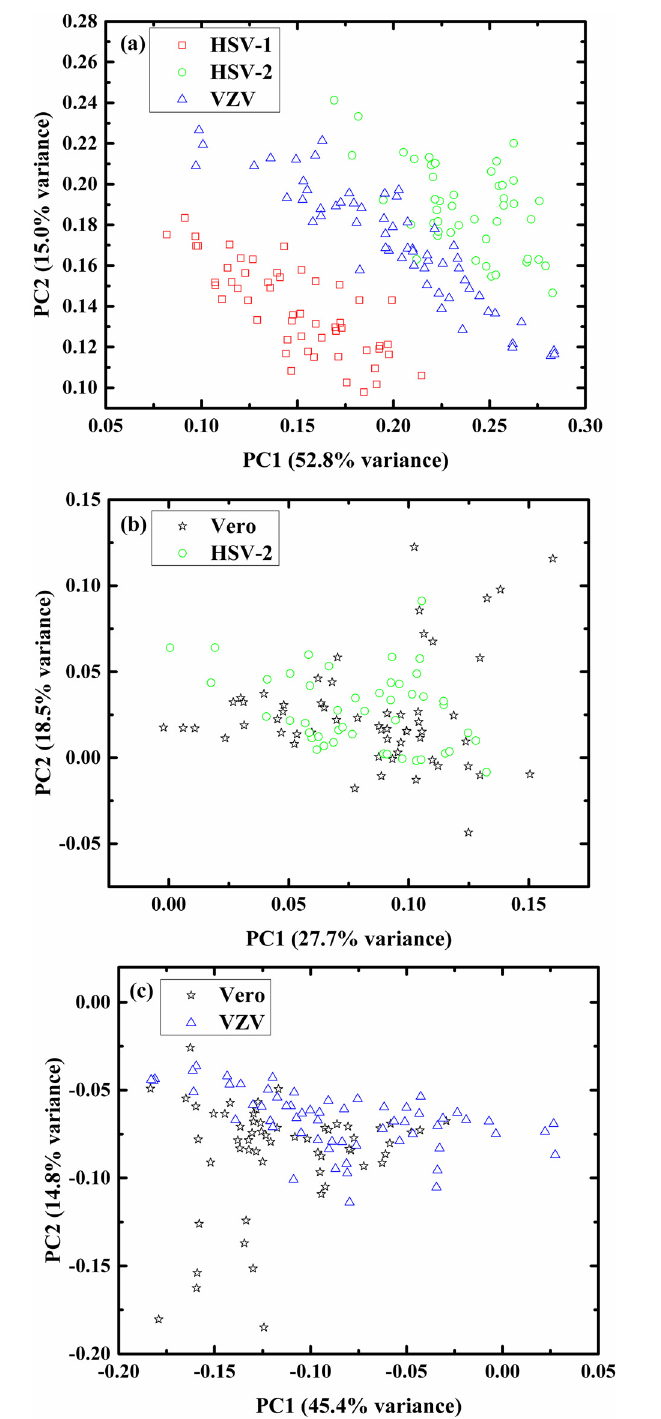
Fig 3. Plotting PC's scores calculated by PCA in two-dimensional plots. 2D figure of the different biological samples investigated in this study. In this figure the scores are shown for PC1 versus PC2: (a) HSV-1 infected Vero cells, HSV-2 infected Vero cells, and VZV infected Vero cells; (b) Vero cells, HSV-2 infected Vero cells; and (c) Vero cells, VZV infected Vero cells.